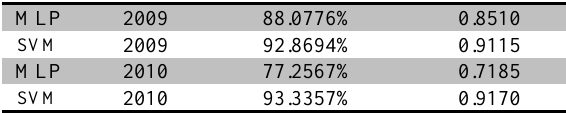
Table 1. The accuracy of classification methods